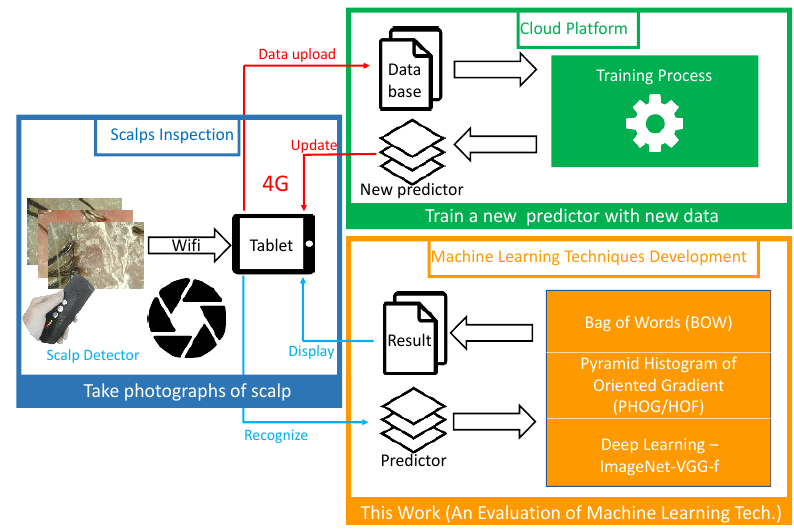
Figure 3. System architecture of the intelligent scalp detection system (ISDS).